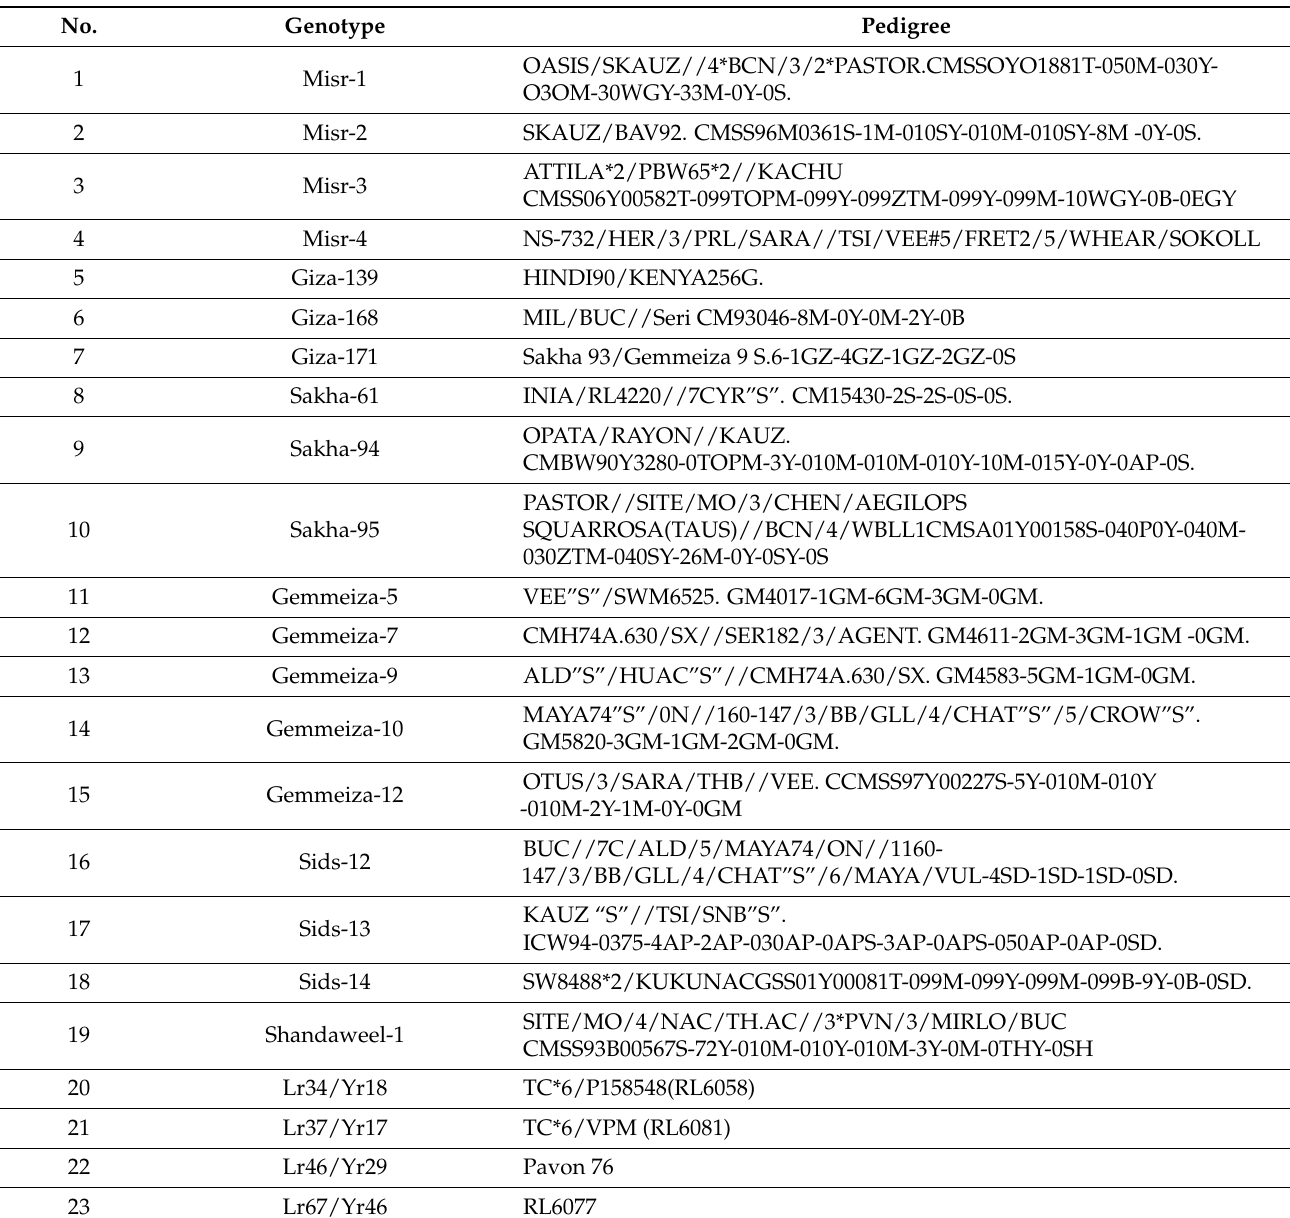
Table 1. List of the tested wheat genotypes that were used in this